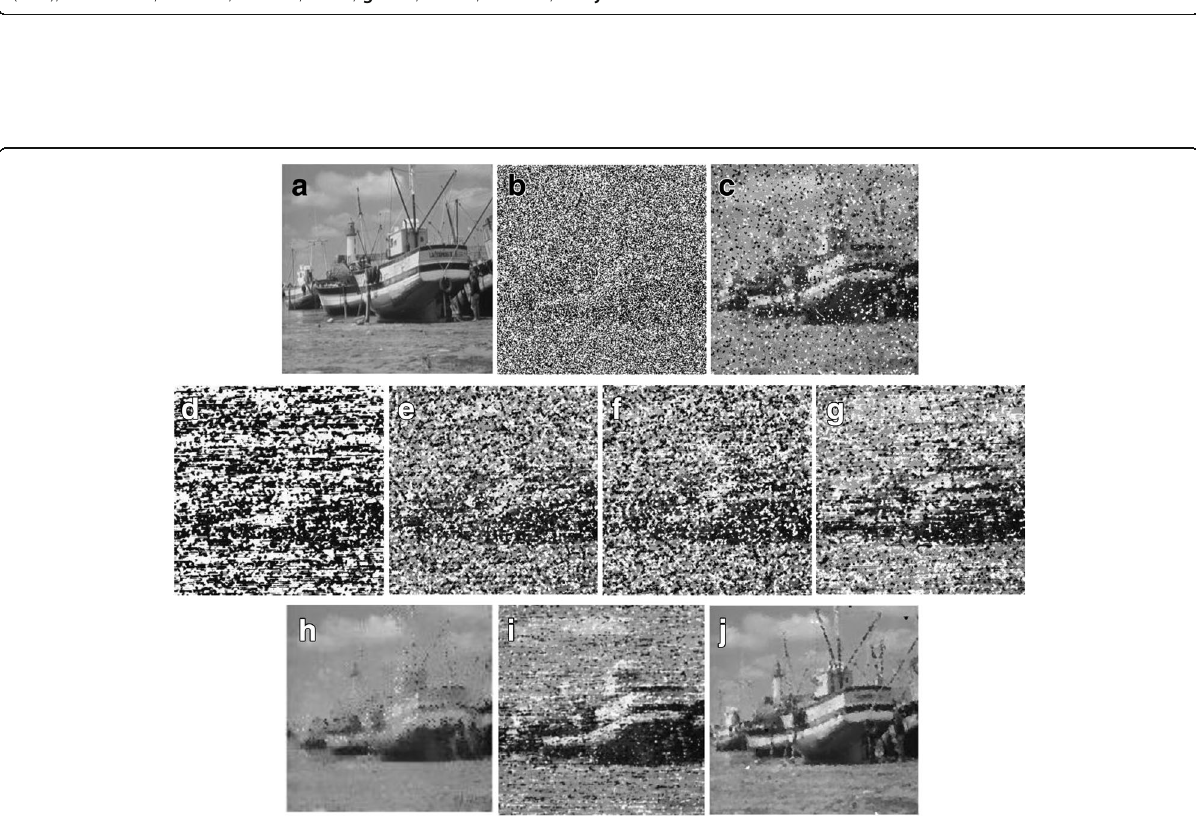
Fig. 6 Restoration results of different methods for Lena image corrupted with 80% noise density. Legends: a Lena (original image); b noisy image (80%); c NAFSWM; d ROAD; e ROLD; f TBLI; g ASM; h CBD; i AFIDM; and j TTSD